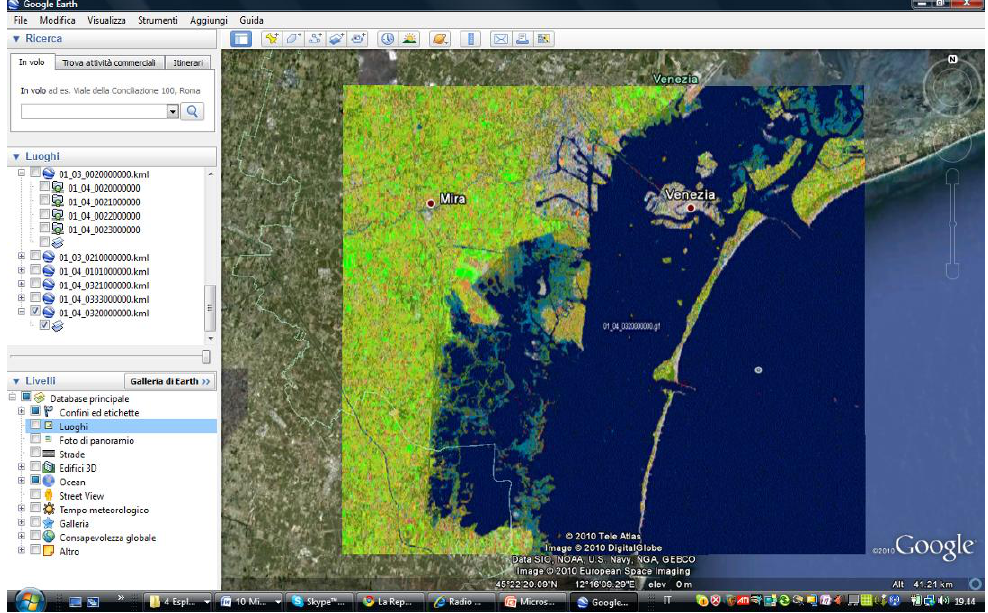
Figure 15. Preliminary classification map, depicted in pseudo colors, generated by L-SIAM™ from a Landsat-7 ETM+ image of the Venice lagoon, Italy, radiometrically calibrated into TOARF values, spatial resolution: 30 m. The L-SIAM™ map is transformed into the kml data format and loaded as a thematic layer in a commercial 3-D earth viewer (e.g., Google Earth).